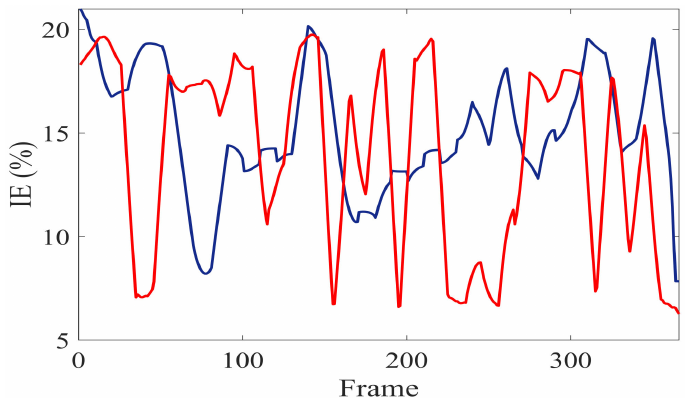
Figure 13. The wind retrieved error of different frames using the up-sampled data (blue) and the fully sampled data